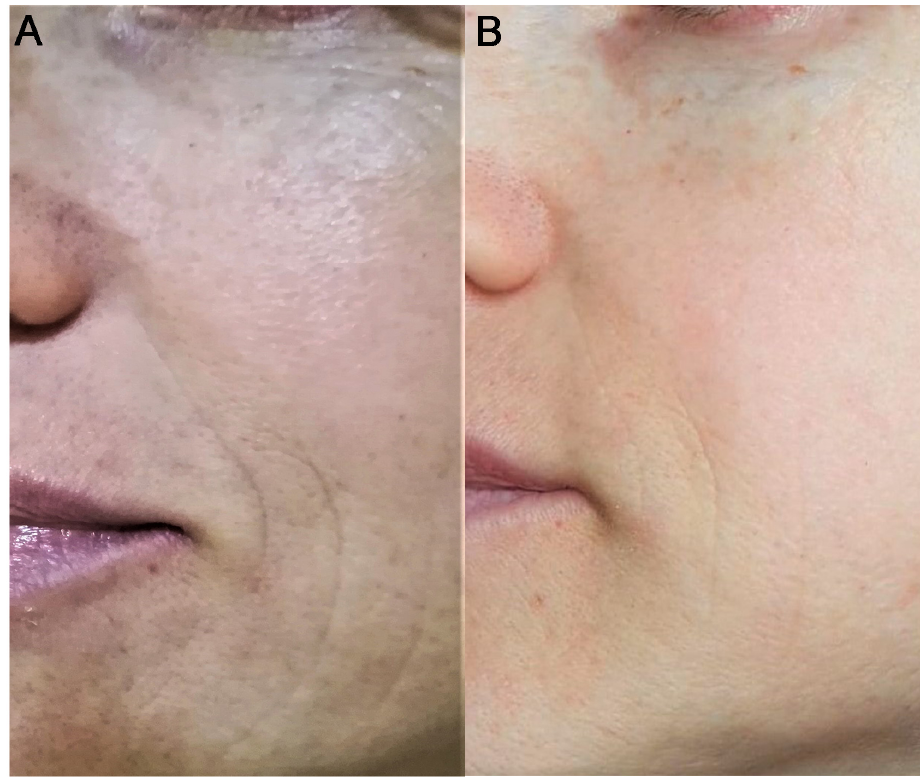
Figure 5. Example of treatment on a patient. ( A ) before treatment; ( B ) 80 days after treatment.